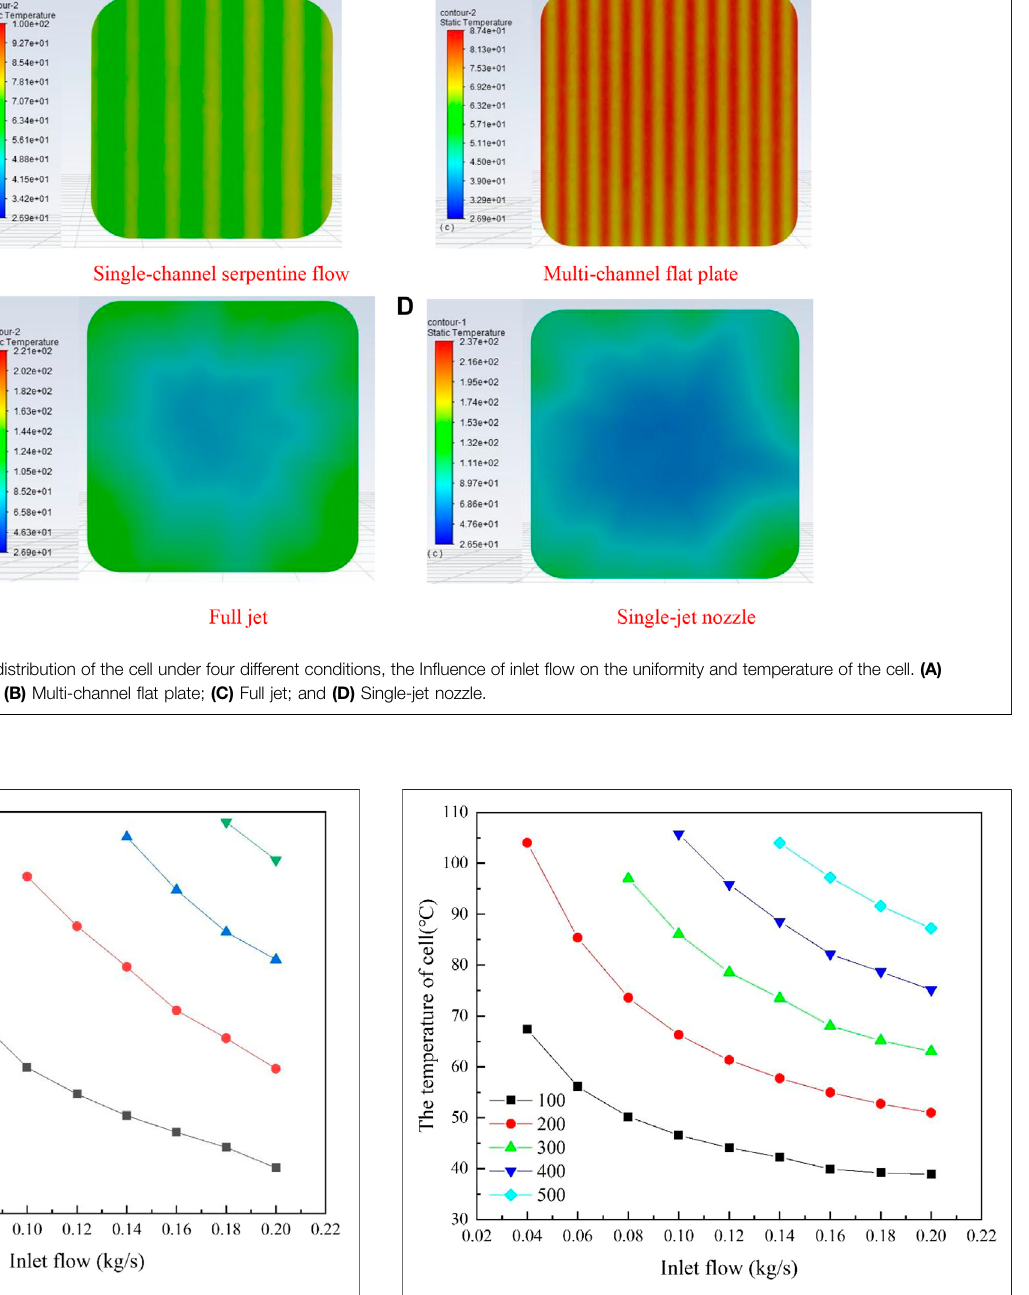
FIGURE 7 | In fl uence of inlet fl ow on the temperature of the